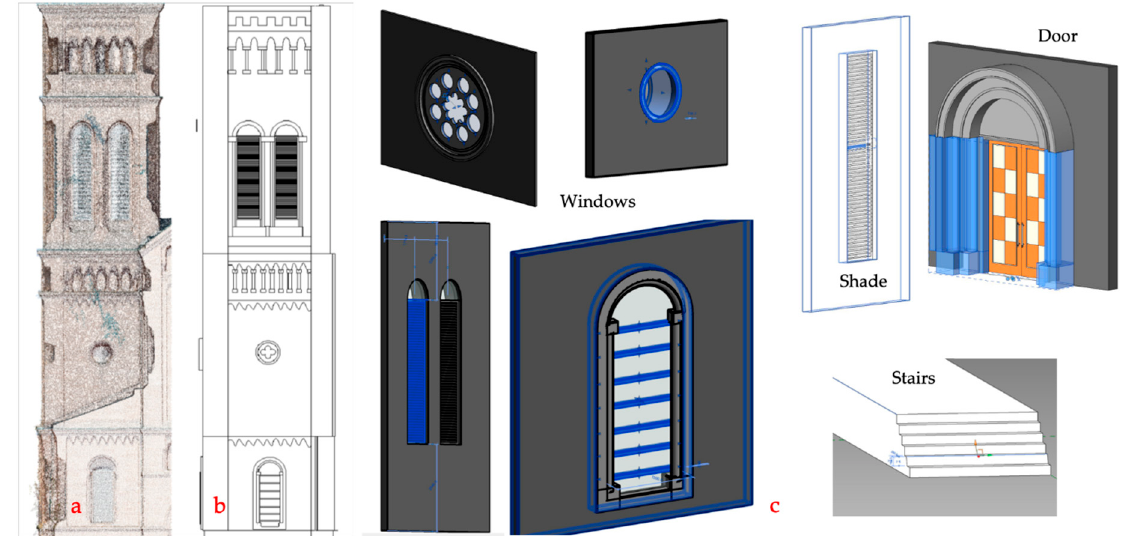
Figure 3. ( a ) The point clouds imported in BIM platform, ( b ) the HBIM structures created by reverse design, and ( c ) some typical “classes” composing the church on the reference of the point cloud